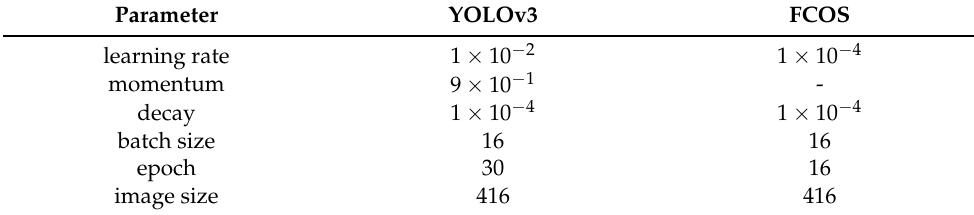
Table 2. Training parameters.